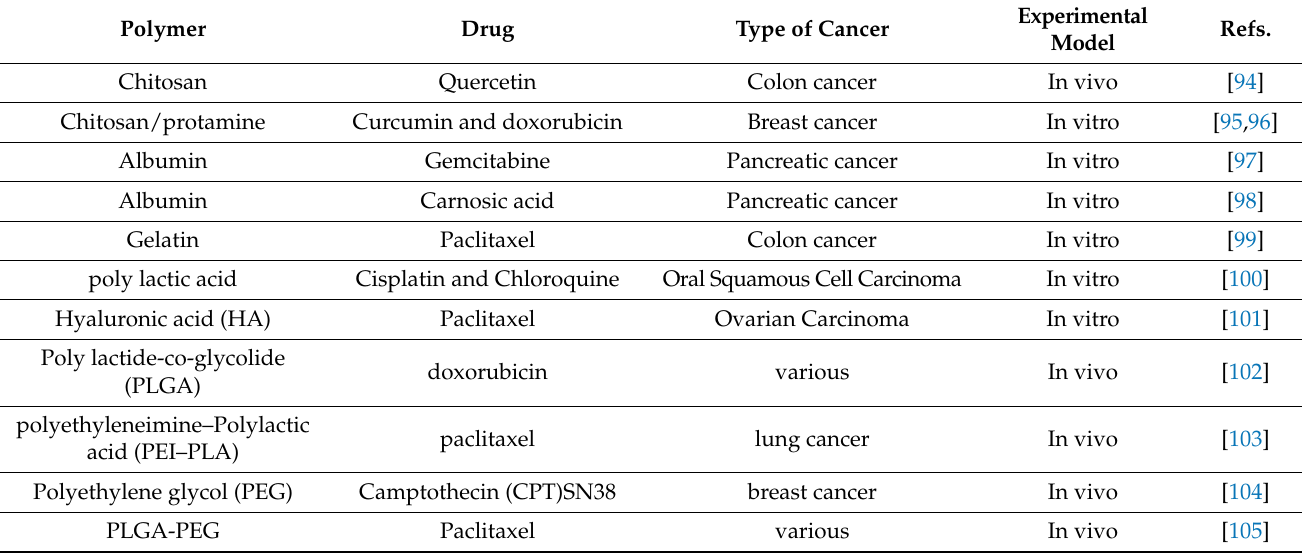
Table 2. Drugs and their used nanocarriers in different